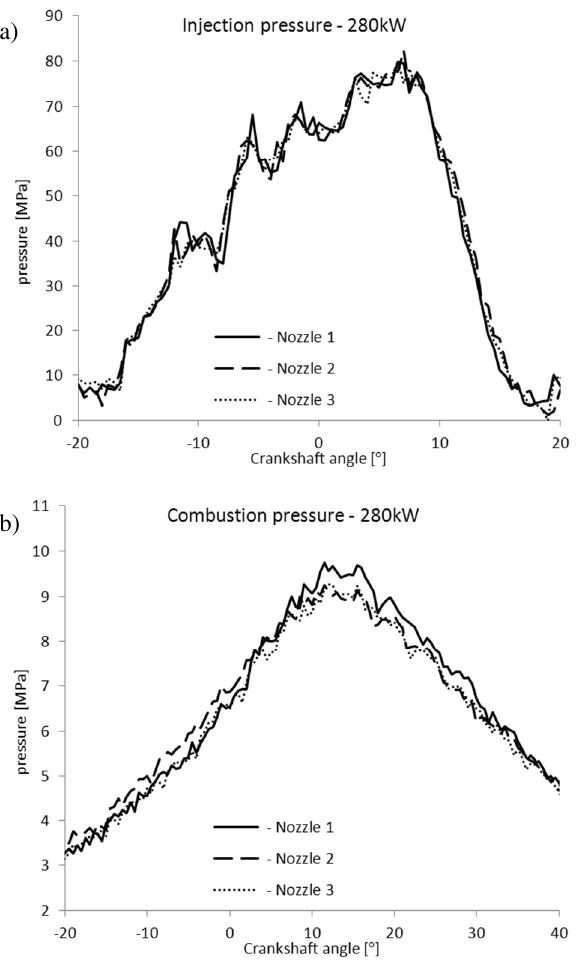
Fig. 2. The example of a) fuel injection pressure and b)combustion pres- sure